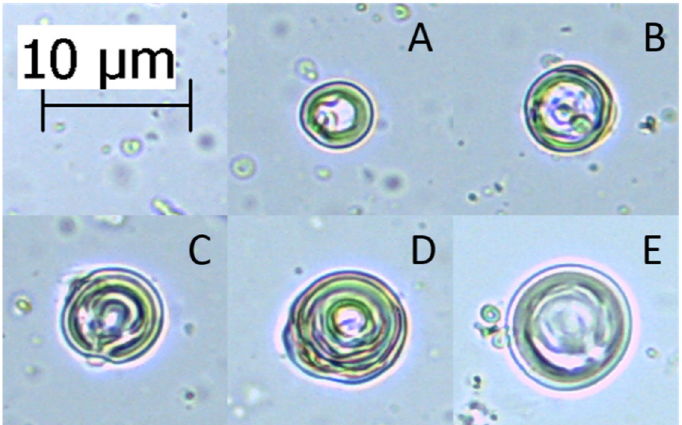
Figure 3. Light microscopy images of different types and sizes of dipalmitoyl-phosphatidylcholine (DPPC) liposomes and its mixture including chrysin, quercetin, caffeic acid and trans -ferulic acid (DPPC:chrysin/caffeic acid/ trans -ferulic acid [n/n], 5:1; DPPC:quercetin [n:n], 10:1) as suspensions in HEPES buffer (20 mM, pH 7.0) (magnification, 400 × ). ( A , C – E ) Multilamellar vesicles. ( B ) Multi- vesicular vesicle. All images include, besides the one bigger liposome in the centre, a larger number of smaller liposomes for size